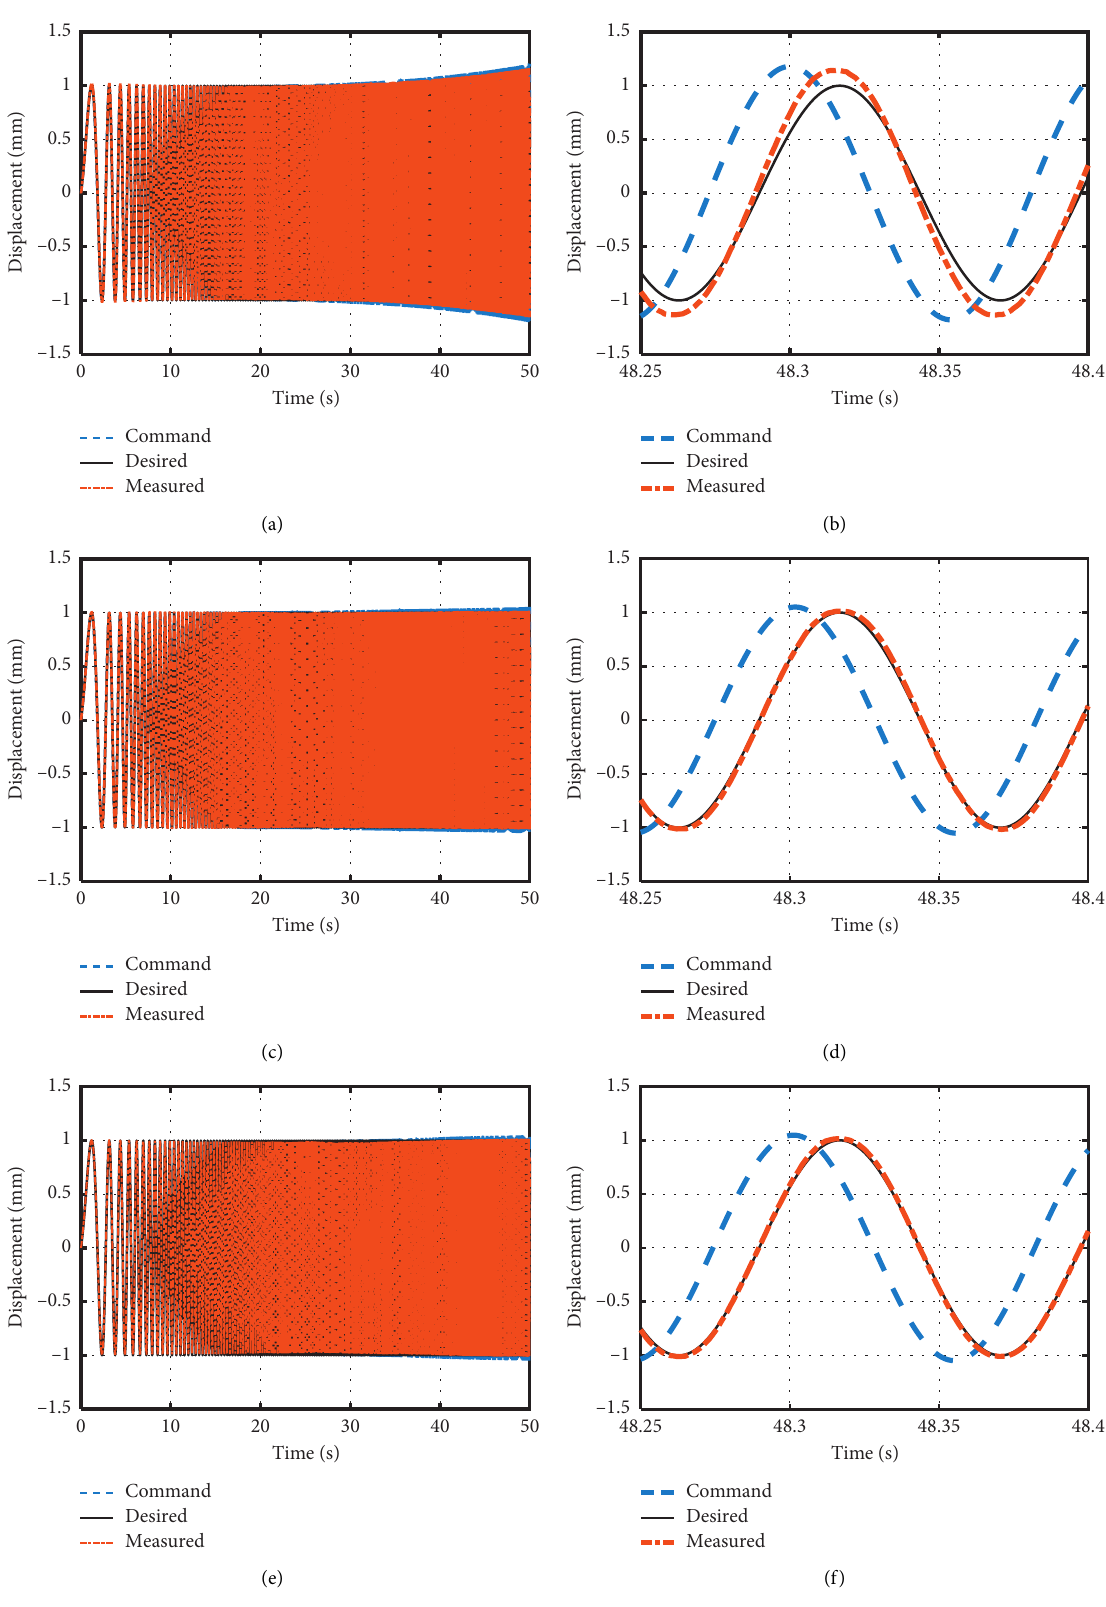
Figure 6: Displacement time histories with swept loading target. (a) Displacements obtained with the PE method. (b) Enlarged view of (a). (c) Displacements obtained with the SADC method. (d) Enlarged view of (c). (e) Displacements obtained with the TADC method. (f) Enlarged view of